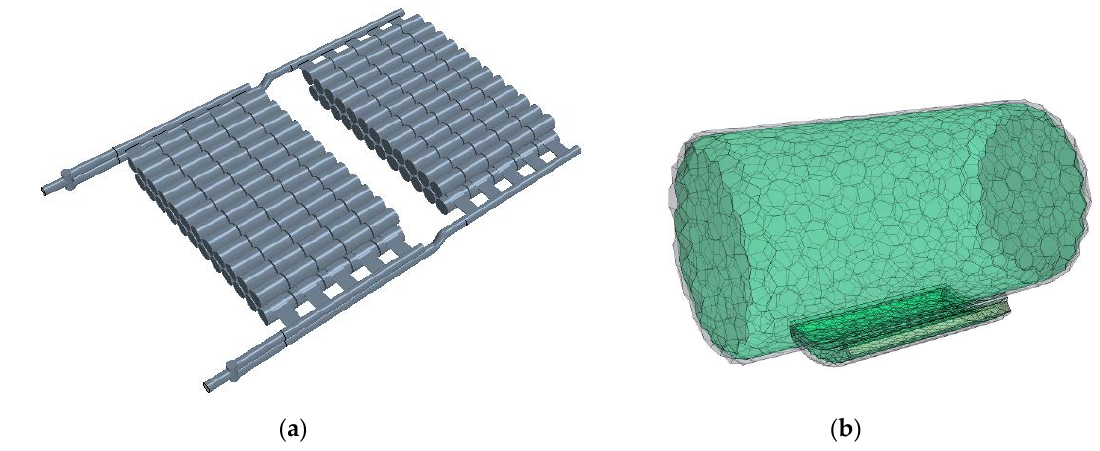
Figure 7. Geometry models: ( a ) battery cells with a cooling plate; ( b ) single-battery heat transfer model (grid level 1).